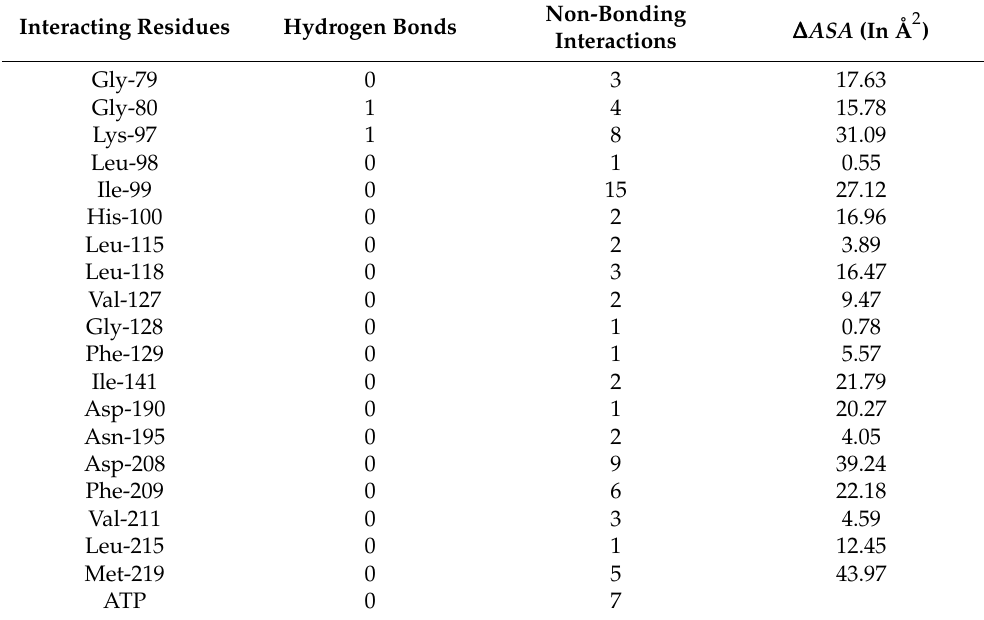
Table 3. The MEK1 residues interacting with selected flavonoid (CID: 10813589) are listed with the number of non-bonding interactions and ∆ ASA